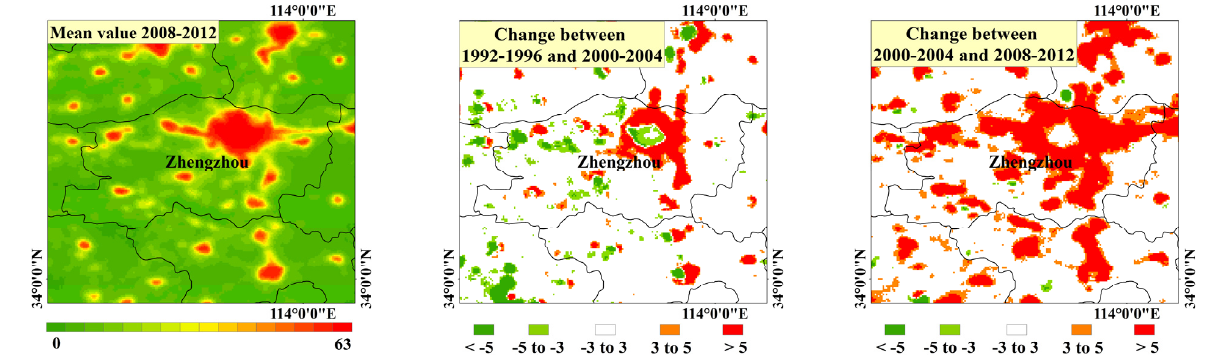
Figure 9. Change trends in detected nighttime light among large